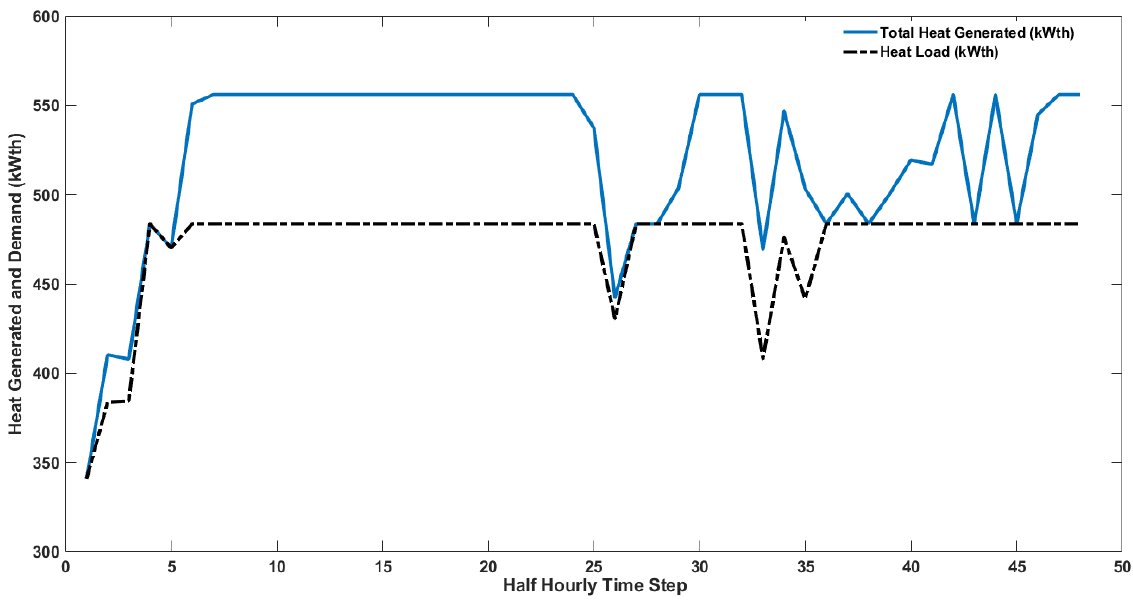
Figure 14. Total heat generated by the CHP units and heat demand (offline optimisation).